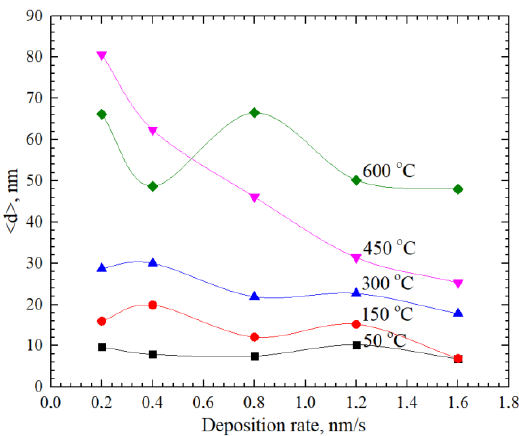
Figure 5. Change of SDC20 crystallite size with the respect to deposition rate from 0.2 nm/s to 1.6 nm/s.